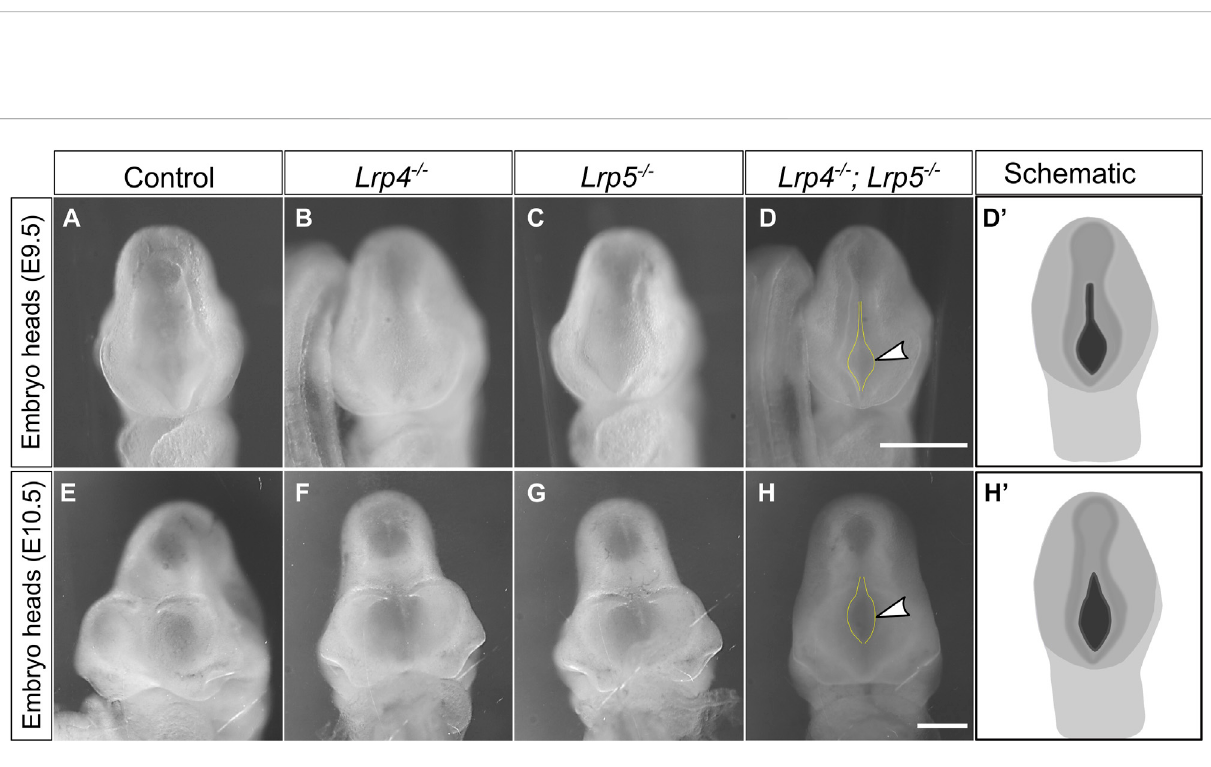
FIGURE 2 Loss of both, LRP4 and LRP5, leads to impaired cranial neural tube closure. (A – C) At E9.0 and E9.5 (somite stages 20 – 25) all Lrp4 − / − single mutant mouseembryos (B) ( n =5),all Lrp5 − / − mutants (C) ( n =3)andallwild-typelittermatecontrols (A) ( n =5)displayedaclosedanteriorneuropore(ANP). (D) In contrast, 88% of all Lrp4 − / − ; Lrp5 − / − double mutant embryos (8 out of 9) had an open anterior neuropore (frontal view of whole embryo heads, dotted yellowlinesandarrowheadindicatetheopenANP,scalebar:500 µm); (D 9 ) SchematicindicatingtheopenanteriorneuroporeatE9.5inblack. (E – G) AtE10.5wild-typecontrols (E) ( n =3), Lrp4 − / − embryos (F) ( n =4),and Lrp5 − / − embryos (G) ( n =3)displayednormalcrossmorphologyoftheforebrainand the ANP was closed (frontal view of whole embryo heads). (H) 80% of the Lrp4 − / − ; Lrp5 − / − double mutant embryos showed an open anterior neuropore (dotted line and arrowhead) at E10.5 (4 out of 5 embryos). Scale bar: 500 μ m. (H 9 ) Schematic indicating the open anterior neuropore at E10.5 in